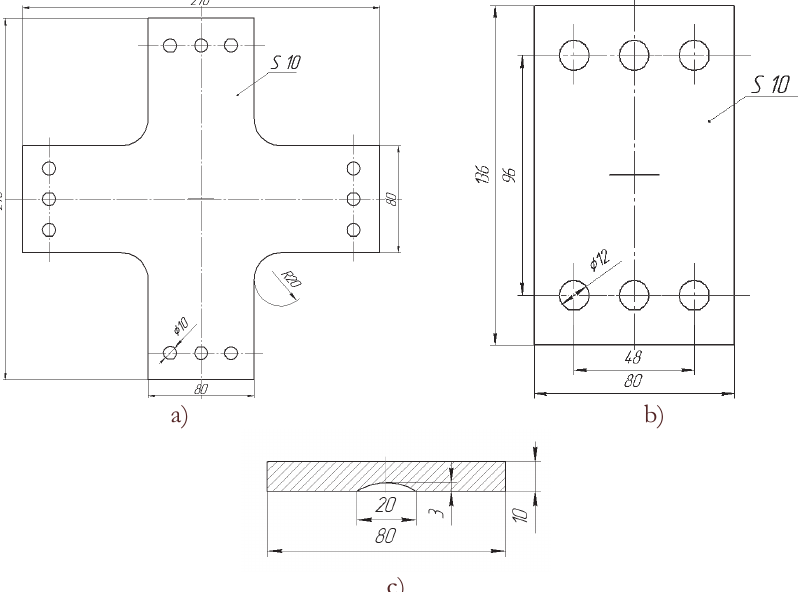
Figure 1: Details of the (a) cruciform specimen and (b) plate geometry and (c) initial notches.